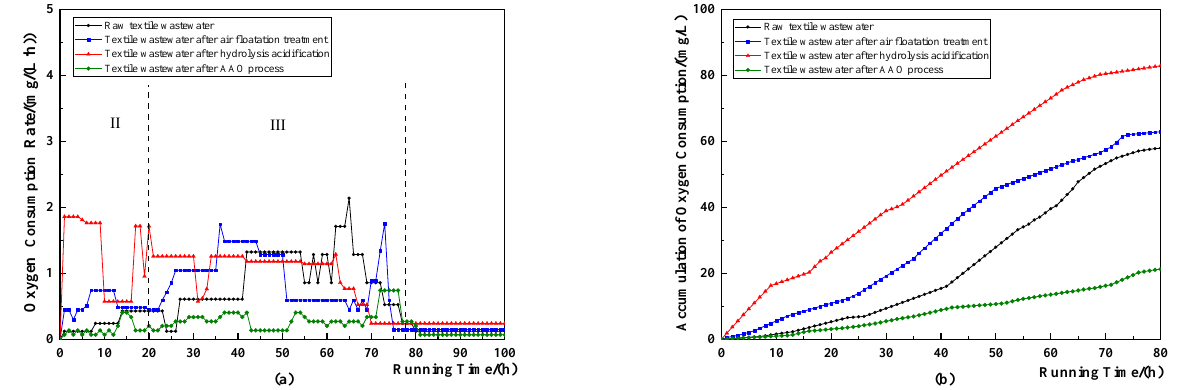
Figure 5. The oxygen consumption process of textile wastewater in different treatment stages (( a ) Oxygen consumption rate; ( b ) Cumulative oxygen consumption).